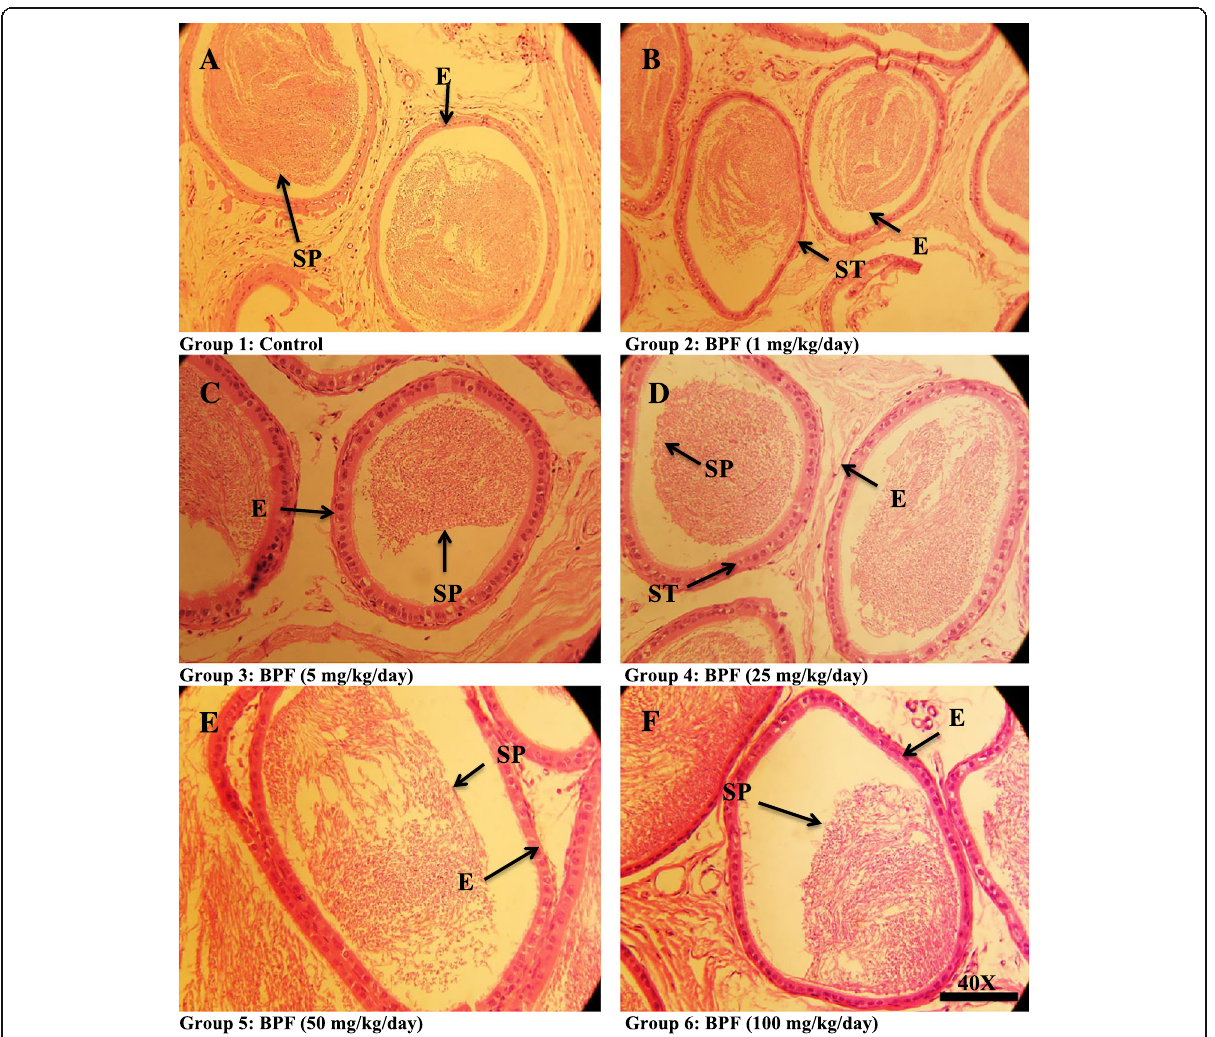
Fig. 3 Photomicrograph of cauda epididymis tissue showing a control; with compact arrangement of cauda tubules with sperm-filled lumen. b BPF (1 mg/kg/day)-exposed group, presenting normal caput tubules like in the control. c BPF (5 mg/kg/day)-exposed group, presenting cauda tubules with sperm-filled lumen. d BPF (25 mg/kg/day-exposed group presenting cauda tubules with less sperm in the lumen. Similarly, e BPF (50 mg/kg/day)-exposed group presenting cauda tubules with fewer sperm in the lumen. Likewise, f BPF (100 mg/kg/day)-exposed group presenting cauda tubules with empty spaces and fewer number of sperm in the lumen. Presenting SP, spermatozoa, ST, seminiferous tubules; E, epithelium. H&E (×